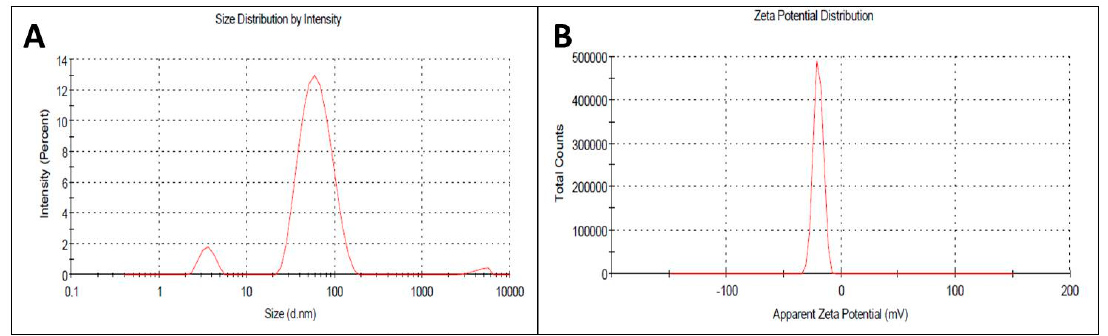
Figure 3. ( A ) Size distribution of synthesized AgNPs; ( B ) Zeta potential of synthesized AgNPs by DLS analysis.